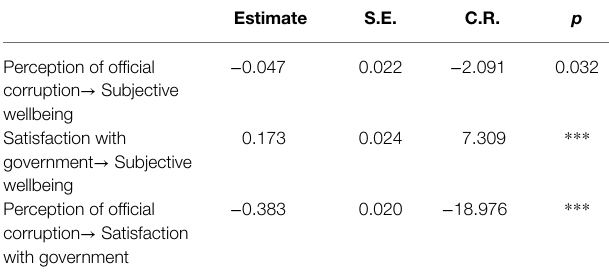
TABLE 5 | Regression weights of the model. Estimate